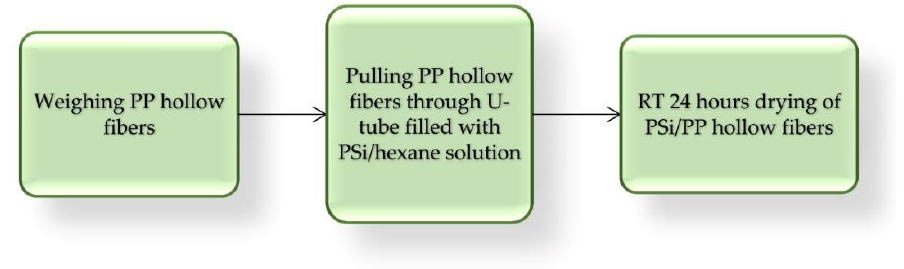
Figure 5. Block diagram of PSi coating PP tubing. Table 2. PP tubing coated with PSi layer.